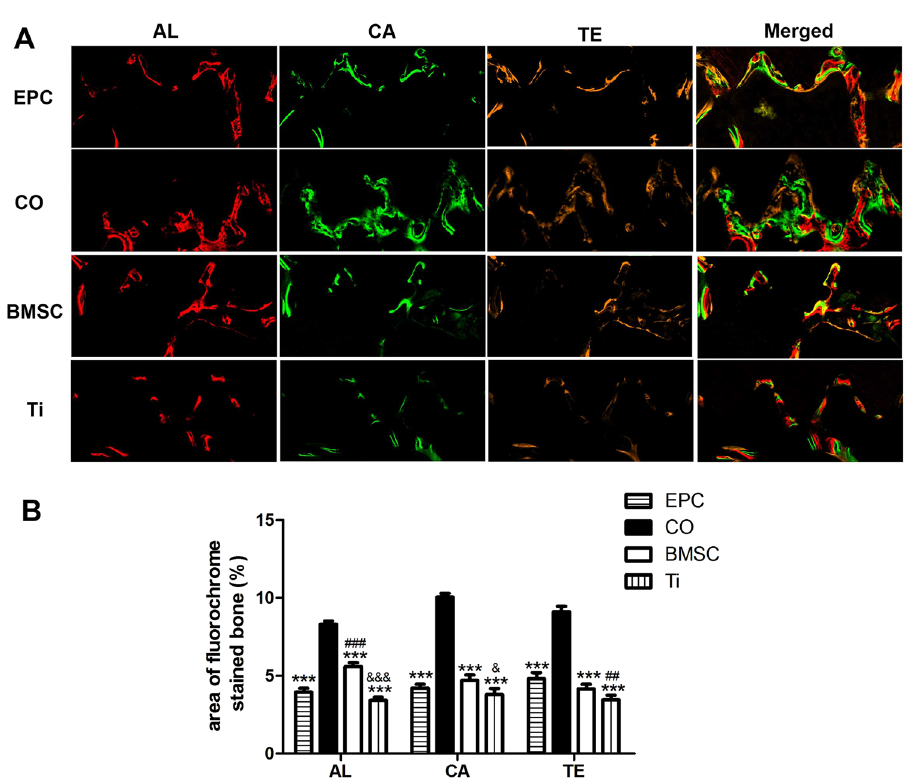
Figure 6. Sequential fluorescent labeling of bone formation and mineralization. ( A ) Red, green and yellow represent labels of Alizarin Red S (AL), Calcein (CA) and Tetracycline Hydrochloride (TE) respectively for each group and merged images of the three fluorochromes for the same group (Original magnification x100). ( B ) The graph shows the percentage of the three fluorochromes area in each group. ( *** p < 0.001 vs CO, ## p < 0.01, ### p < 0.001 vs EPC, & p < 0.05, &&& p < 0.001 vs